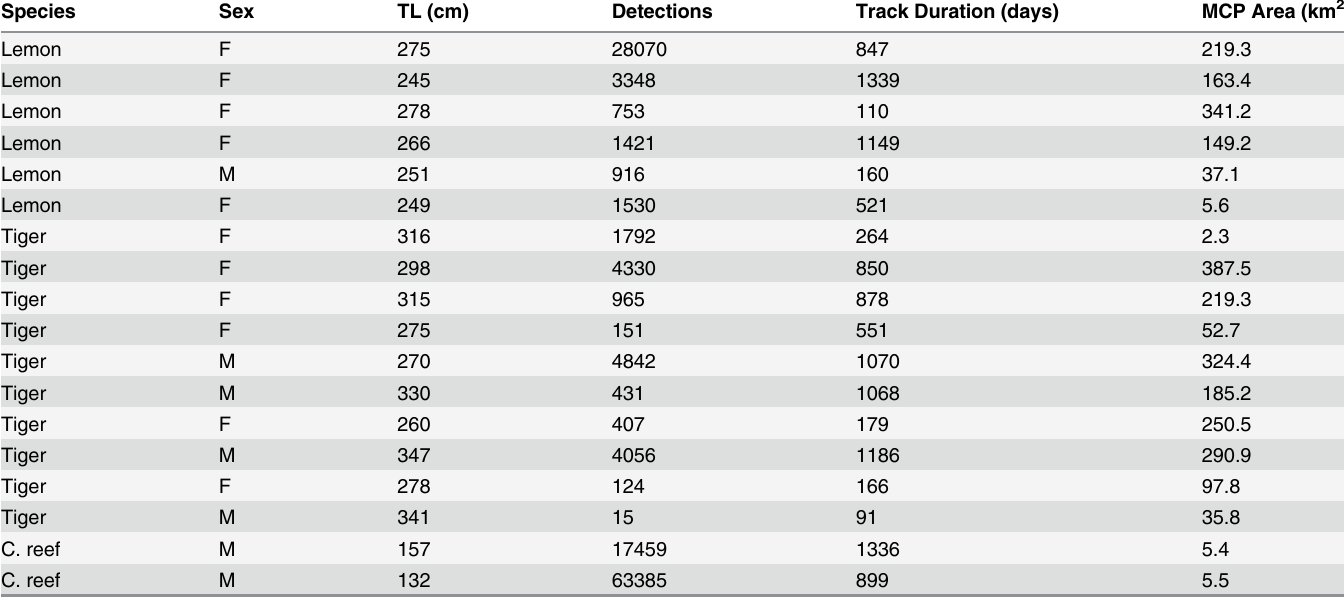
Table 1. Sharks tagged with acoustic transmitters, number of detections on acoustic receivers comprising the mesophotic reef receiver array and track details. Species